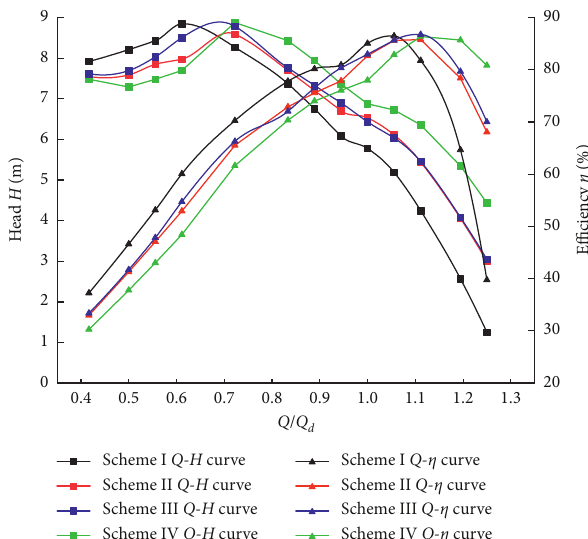
Figure 8: Performance curve of each